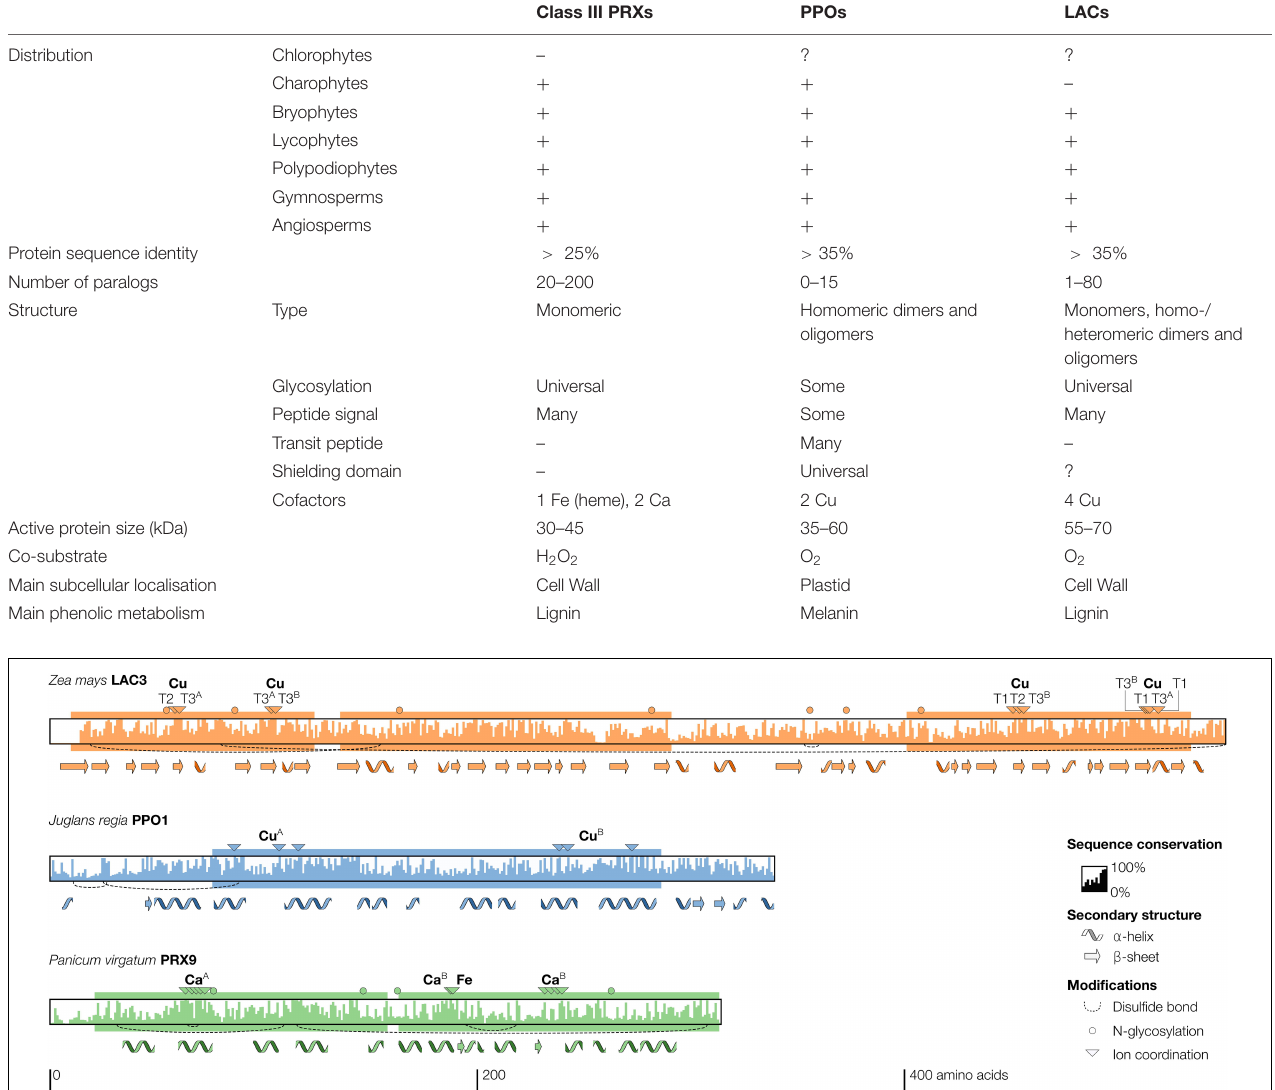
TABLE 1 | Overview of the three groups of phenoloxidases in plants.